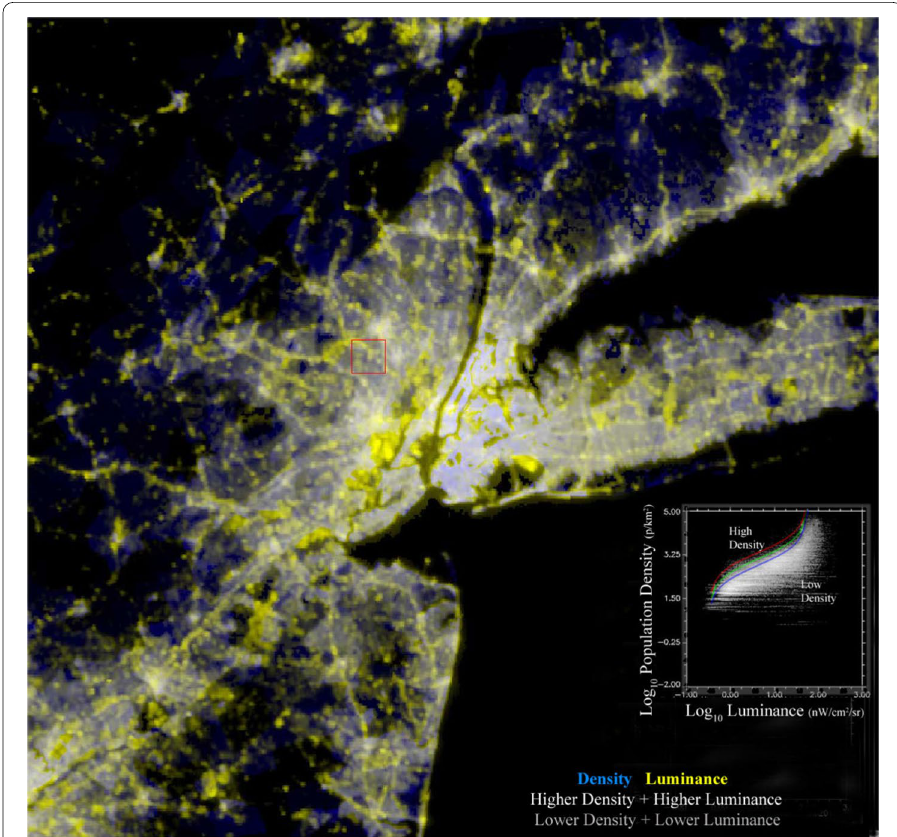
Fig. 3 VIIRS night light and population density in the New York Metro area and central Northeast Corridor. Small, high density census blocks approach the 700 m resolution of the VIIRS sensor so the scaling is clearly resolved on the high density tail. Blue rural areas correspond to larger, lower density census blocks extending into unlighted forest and farmland. Yellow in urban areas corresponds to brightly lighted commercial corridors, industrial areas, seaports and airports. The diffuse low density tail of the bivariate distribution is a result of larger census blocks and